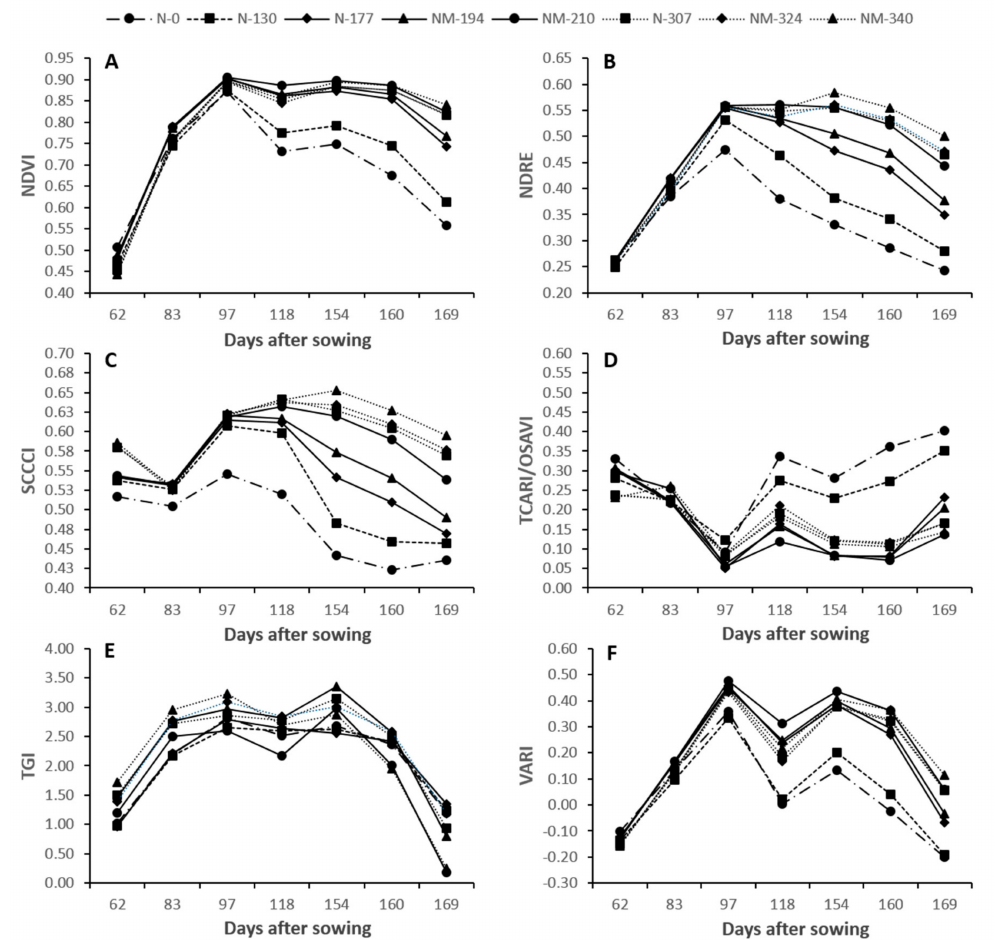
Figure 3. Seasonal evolution of the normalized difference vegetation index (NDVI; A ), normalized difference red edge index, NDRE ( B ), simplified canopy chlorophyll content index (SCCCI; C ), transformed chlorophyll absorption reflectance index normalized by the optimized soil adjusted vegetation index (TCARI/OSAVI; D ), triangular greenness index (TGI; E ) and visible atmospherically resistant index (VARI; F ) for all the fertilization treatments applied in the study. At first cracked boll, a statistically significant relationship was found between all the VIs and both plant N% and N uptake (Table 4). NDRE and SCCCI were at this stage the indices that better performed at differentiating plant N% (r 2 = 0.62 and 0.65, respectively; p < 0.001) and N uptake (r 2 = 0.67 and 0.68, respectively; p < 0.001) between